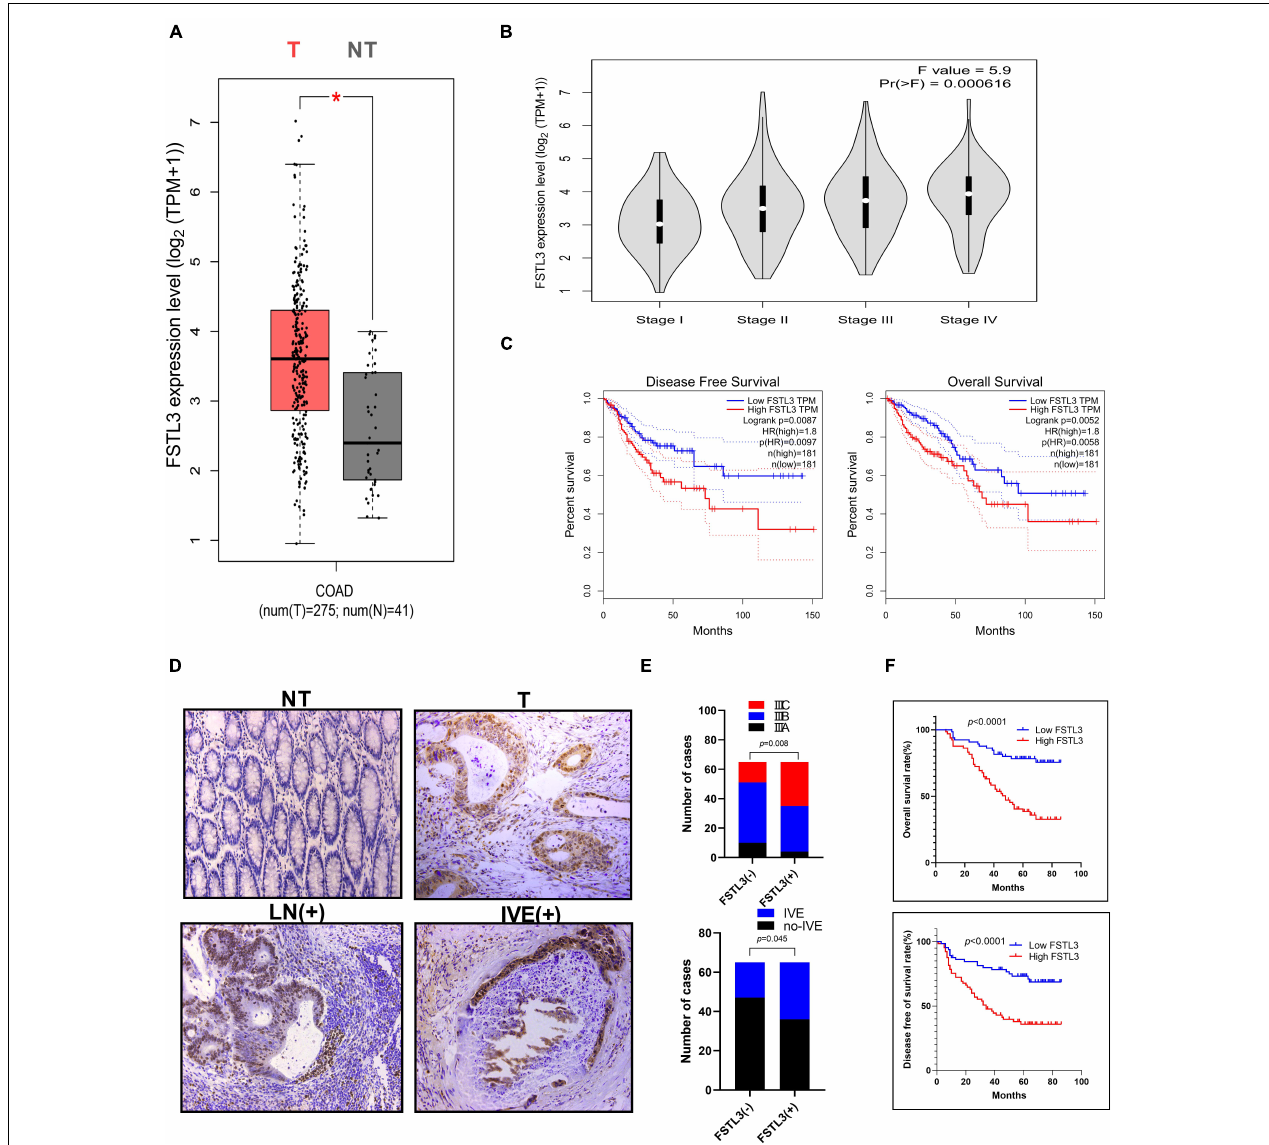
FIGURE 1 | FSTL3 is in CRC. (A) The box plots indicated differential FSTL3 expression between CRC specimens (T) and paired normal tissues (NT), analyzed within the GEPIA database. *Differences were thought to be significant. (B) The pathological stage plot compared FSTL3 expression in different CRC stages, analyzed within the GEPIA database. (C) The survival plots demonstrated that FSTL3 is obviously related to DFS ( p = 0.0087) and OS ( p = 0.0052), analyzed within the GEPIA database. (D) Representative immunohistochemistry images of FSTL3 expression levels in NT, T, LN (metastatic lymph node tissue), and IVE (intravascular emboli). (E) The histogram indicates that FSTL3 expression correlates with tumor stage and IVE. (F) Survival plots were obtained to verify that FSTL3 expression is obviously related to DFS and OS ( p <